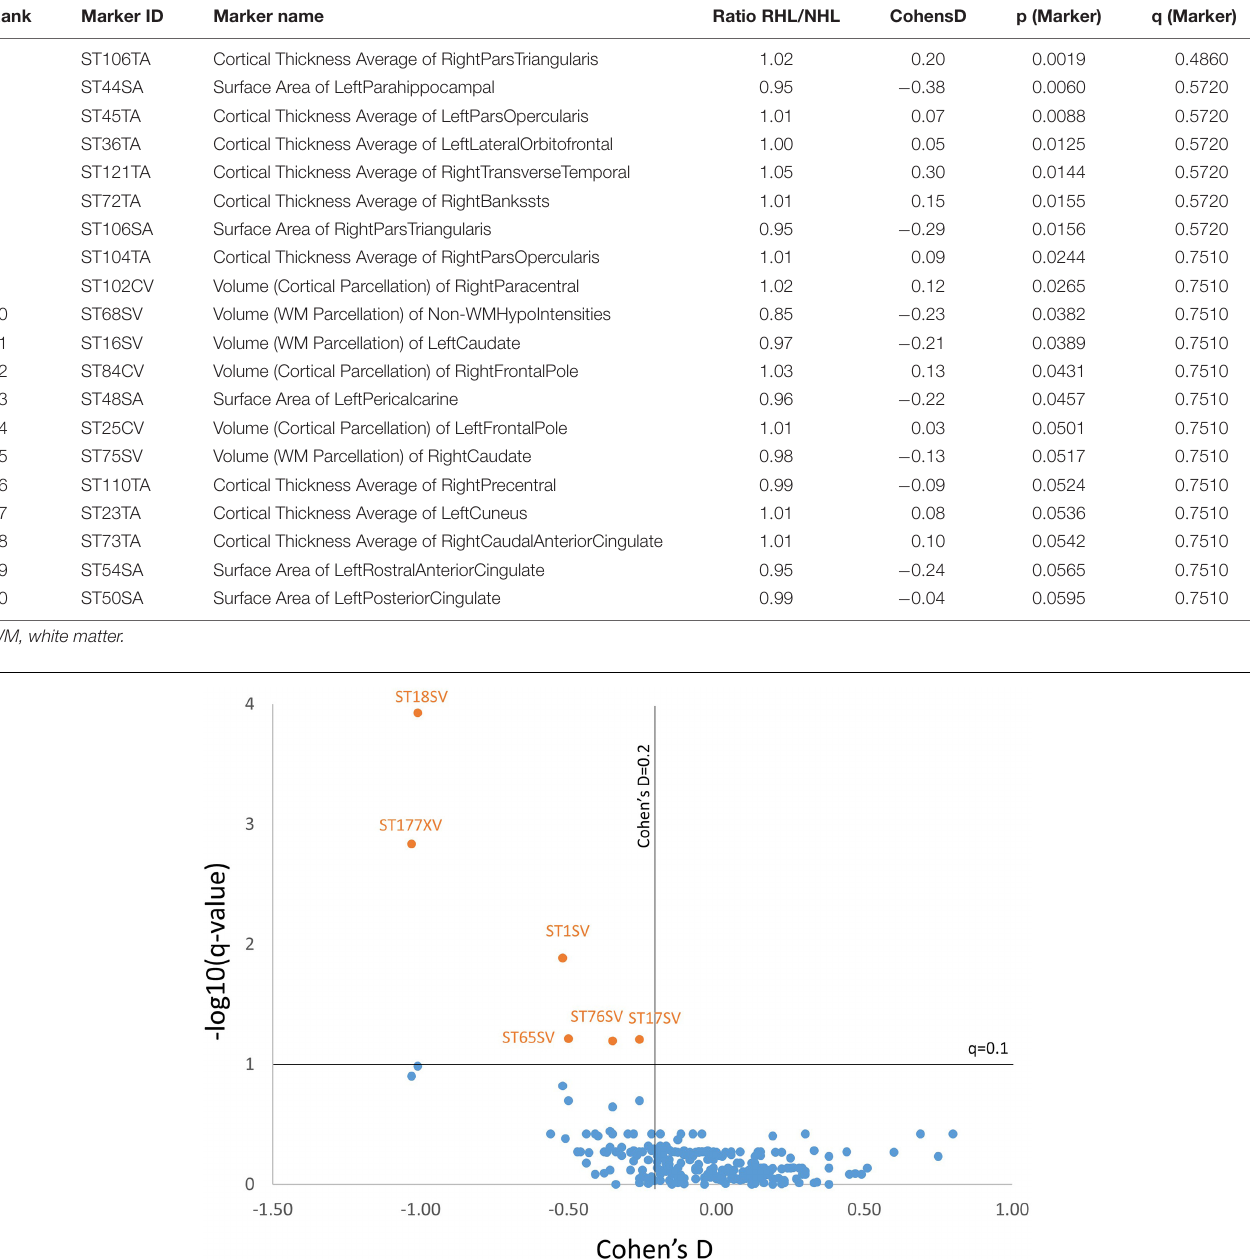
TABLE 3 | Top 20 markers, based on p and q -values, differentiating HL from NHL in MCI subjects, corrected for age and gender.